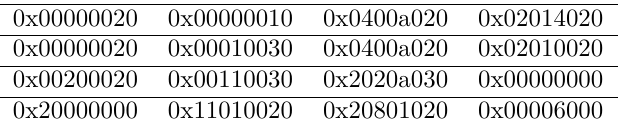
Table 9: Input difference in Phase 2.